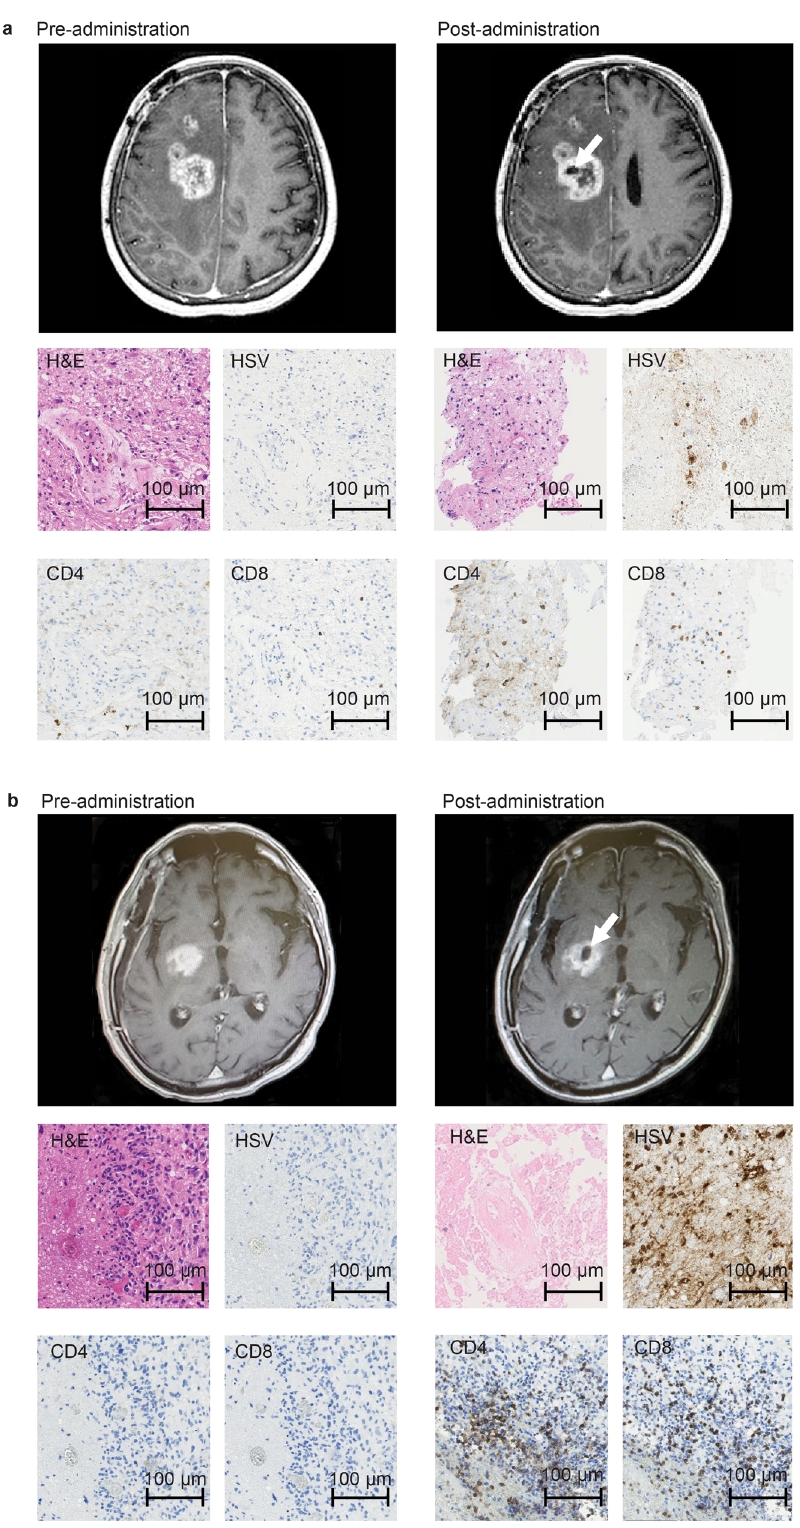
Fig. 2 MRI and histology studies in two patients (a: Patient #6 and b: Patient #10). MRI showed enlargement of the entire enhanced lesion with clearing of contrast enhancement at the injection site (arrows) post-G47 Δ administration. All specimens from pre-administration were negative for HSV-1 immunostaining. Second biopsy specimens obtained before the second injection from the same coordinates of the fi rst G47 Δ injection 7 days ( a ) and 6 days ( b ) post-administration showed decreased number of tumor cells, possibly due to tumor cell destruction associated with viral replication (H&E) and positive HSV-1 immunostaining. An increase in in fi ltration of CD4 + and CD8 + T lymphocytes towards remaining tumor cells was observed. Pathology images are representative of four biopsy